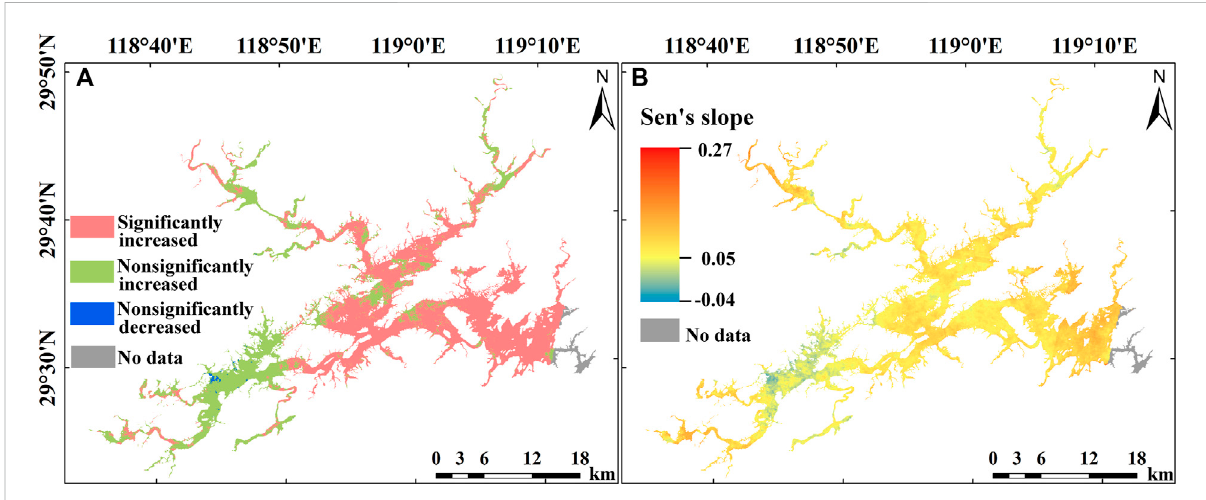
FIGURE 7 Spatial distribution of the long-term LSWT trend (A) and its magnitude (B) in Lake Qiandaohu.